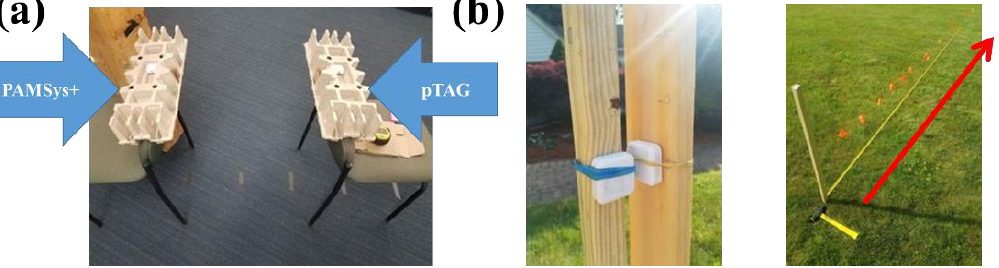
Figure 5. Experimental set-up for proximity detection test: ( a ) was an indoor proximity detection test; and ( b ) was an outdoor proximity test.